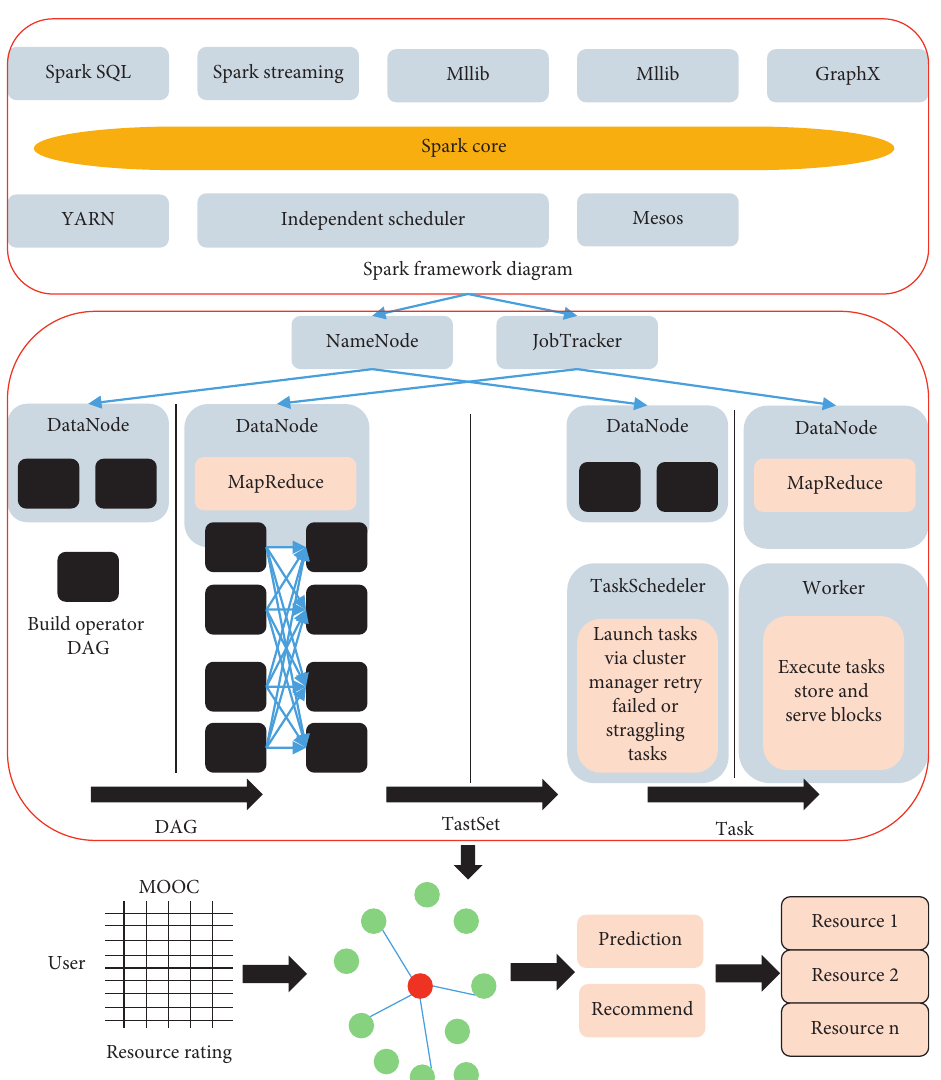
Figure 1: Schematic diagram of the collaborative filtering recommendation algorithm flow based on